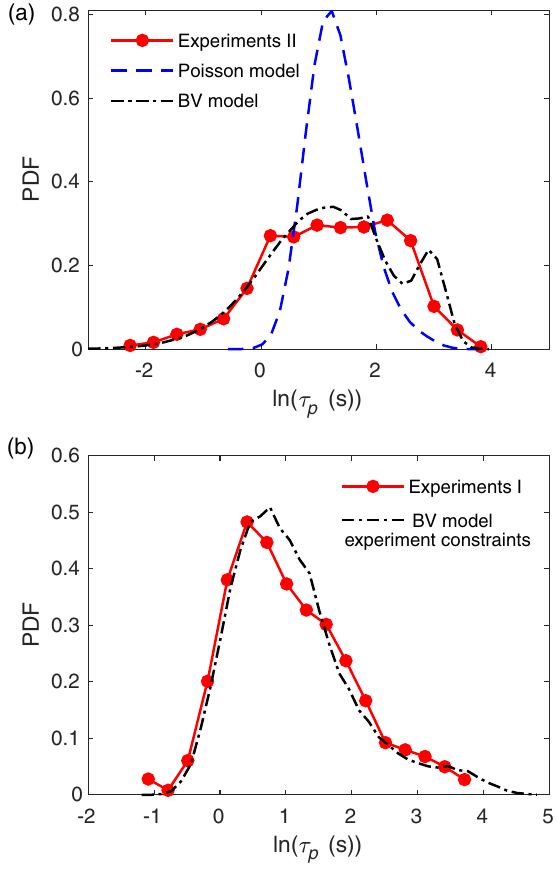
FIG. 7. Probability density function of the logarithm of persist- ence times ð ln τ p Þ . (a) The values τ p are extracted from pieces of track from experiments II that last 20 s. Simulations using two different models are shown: The Poisson model does not reproduce the experiments, while the BV model reproduces the main features. (b) The experimental distribution corresponds to the combined RP437 bacteria in all media, from Fig. 3 in experiments I. “ BV model experiment constraints ” are determined from the same simulations of “ BV model ” but analyzing pieces of trajectories that follow the experimental constraints in this case. It reproduces experiments I without additional free